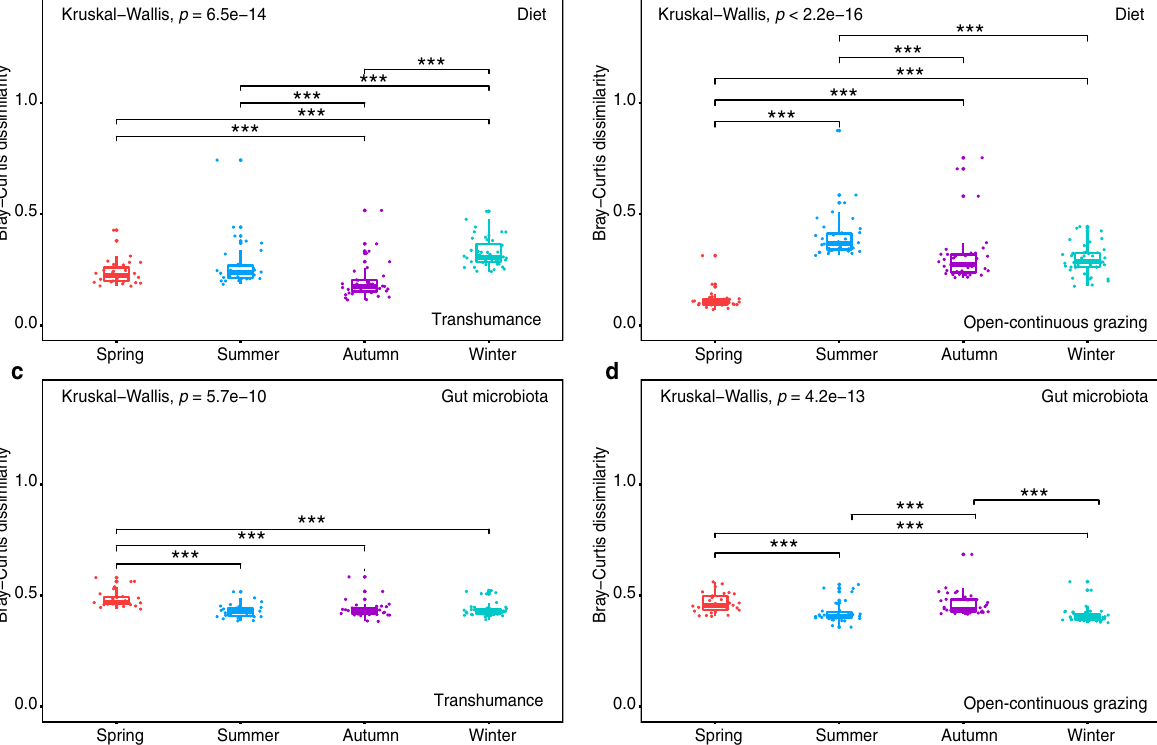
Kruskal−Wallis, p = 6.5e−14